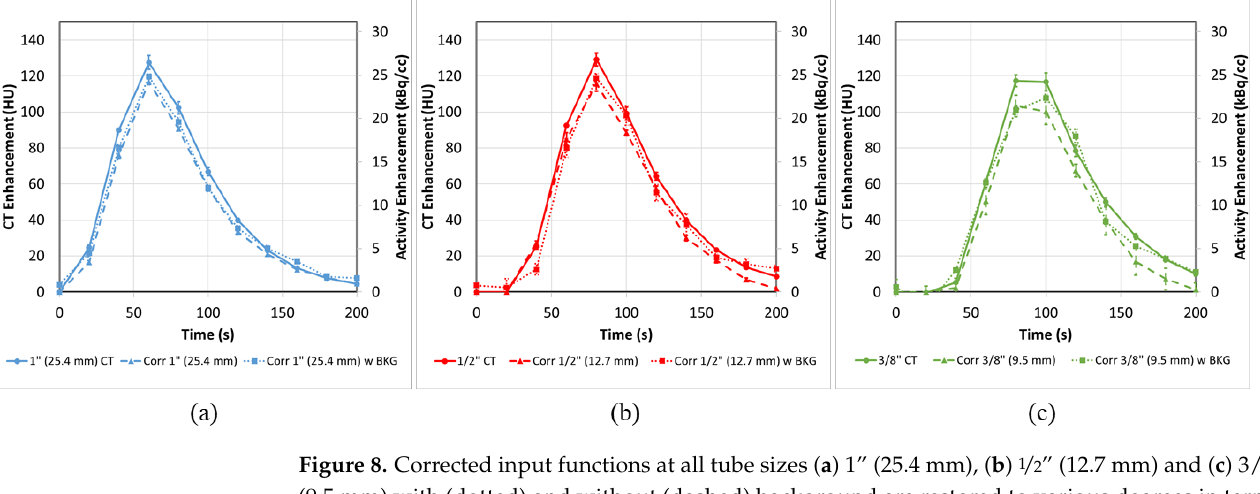
Figure 8. Corrected input functions at all tube sizes (a) 1” (25.4 mm), (b) ½” (12.7 mm) and (c) 3/8” (9.5 mm) with (dotted) and without (dashed) background are restored to various degrees in terms of both peak height and AUC. In the presence of background all three tubes have calculated AUC within 8 ± 9% of ground truth and peak heights within 9 ± 7% of averaged DCE-CT. In the absence of background these values are all somewhat reduced. PET-CT error bars represent the standard error from multiple ROI regions (n = 5). CT error bars represent the experimental range of replicate experiments (n = 2).